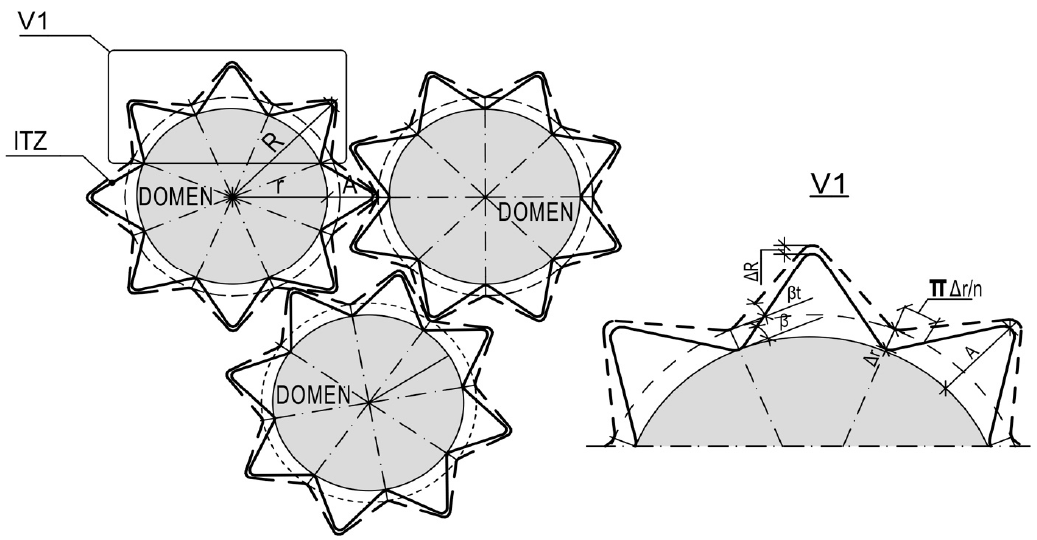
Figure 9. Domain spherulitic model of GP thermal expansion. The primary factors for modelling are: domain radius as r; radius of supra-molecular element (SE) consisting of the domain and flexible molecules as R; spiral wave amplitude as A; radial expansion of domain ∆ r , of SE as ∆ R , of amplitude as ∆ A ; tangential expansion of domain as ∆ x ; total radial relative expansion as ε r ; total tangential expansion as ε x ; angle of the spiral branch slope before and after heating as β и β t with heating temperature change ∆